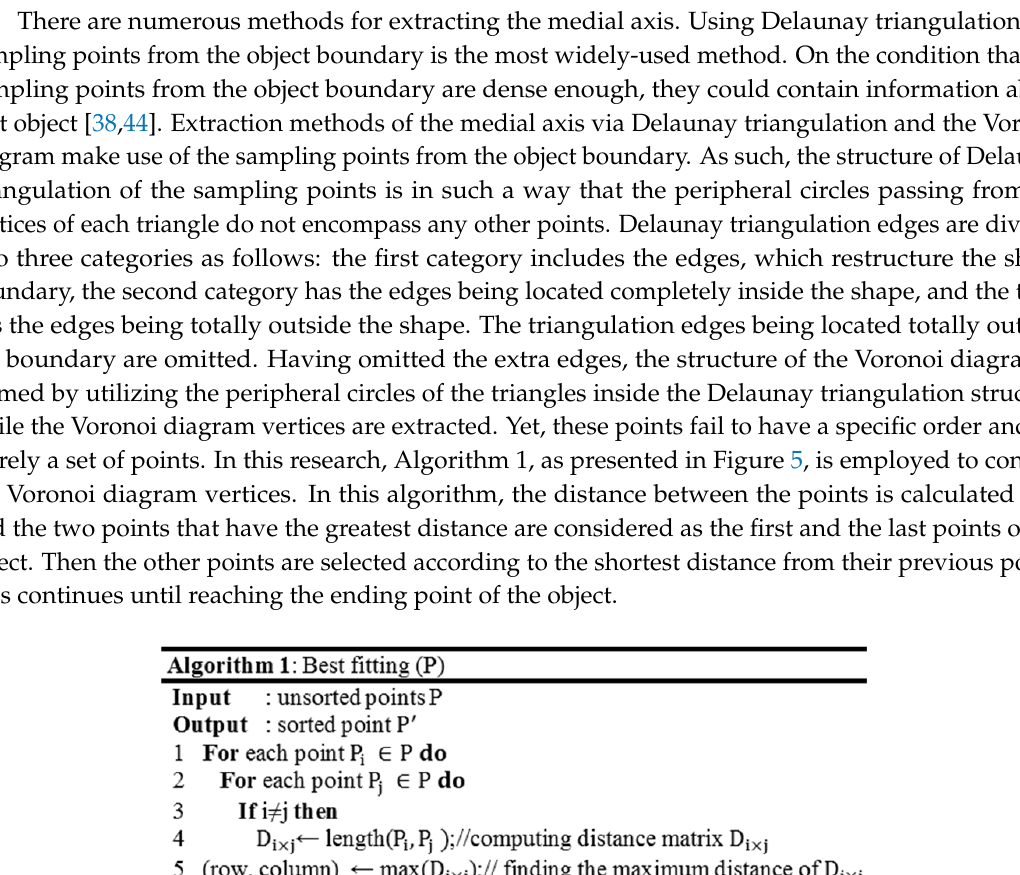
Figure 4. Medial axis for a 2D curve (adapted from [43]).